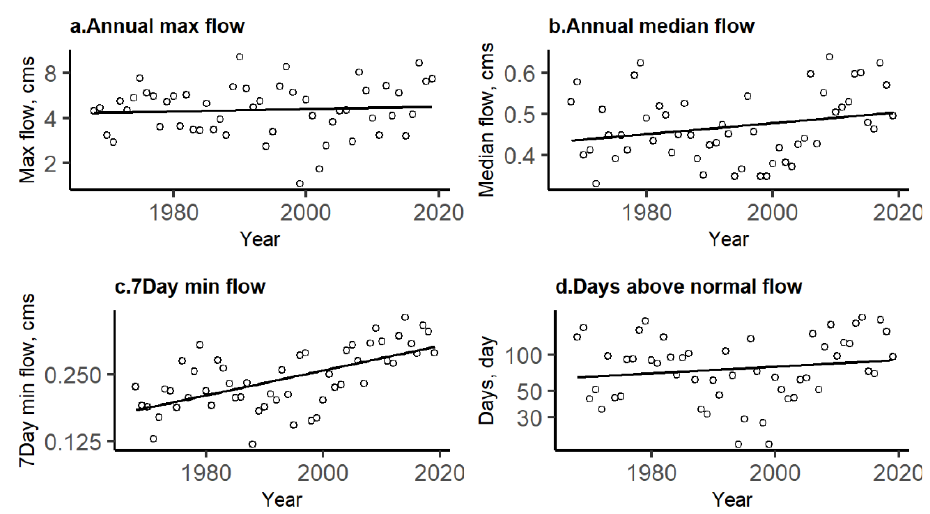
Figure 3. Streamflow regime of the Cataract (rural) gauge located in the main channel. ( a ) Annual max flow, ( b ) Annual median flow, ( c ) 7-day min flow, ( d ) Days above normal flow.